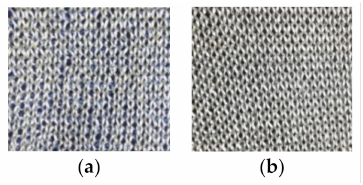
Figure 12. ( a ) Close-up of electrode construction with low yarn density (E1). ( b ) Close-up of electrode construction with high yarn density